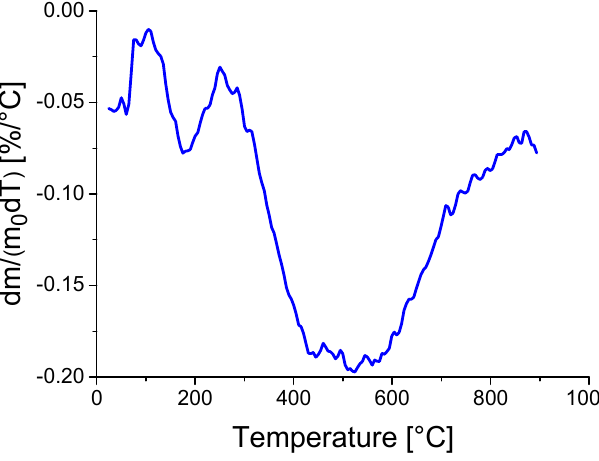
Figure 8. DTG of hydrochar from hydroxymethylfurfural.